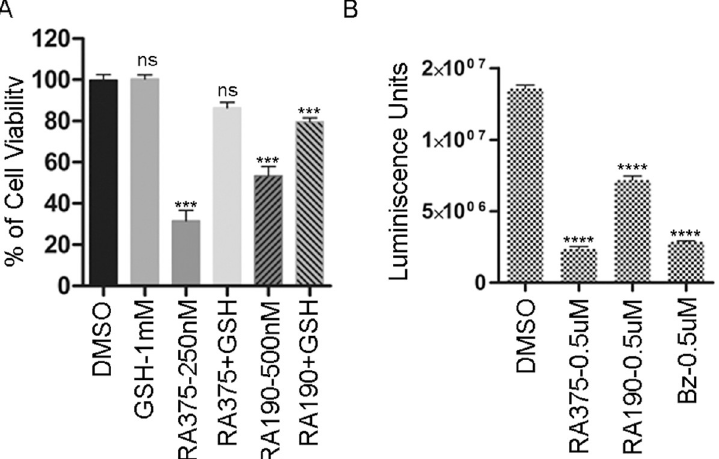
Fig 3. Effect of GSH on RA375 activity. (A) SKOV3 cells (2500 cells/well) were seeded in triplicate in a 96 well plate and one day later were treated with RA375 or RA190 in the presence or absence of GSH (1 mM). Cell viability was measured after 24 hrs using an MTT assay. Significance versus DMSO control (ns = not significant, ��� < 0.001, ���� < 0.0001. (B) SKOV3 cells (250,000/well) were treated in triplicate with DMSO vehicle alone or 0.5 μ M RA375, RA190 or bortezomib (Bz) for 12 hr and the total GSH was